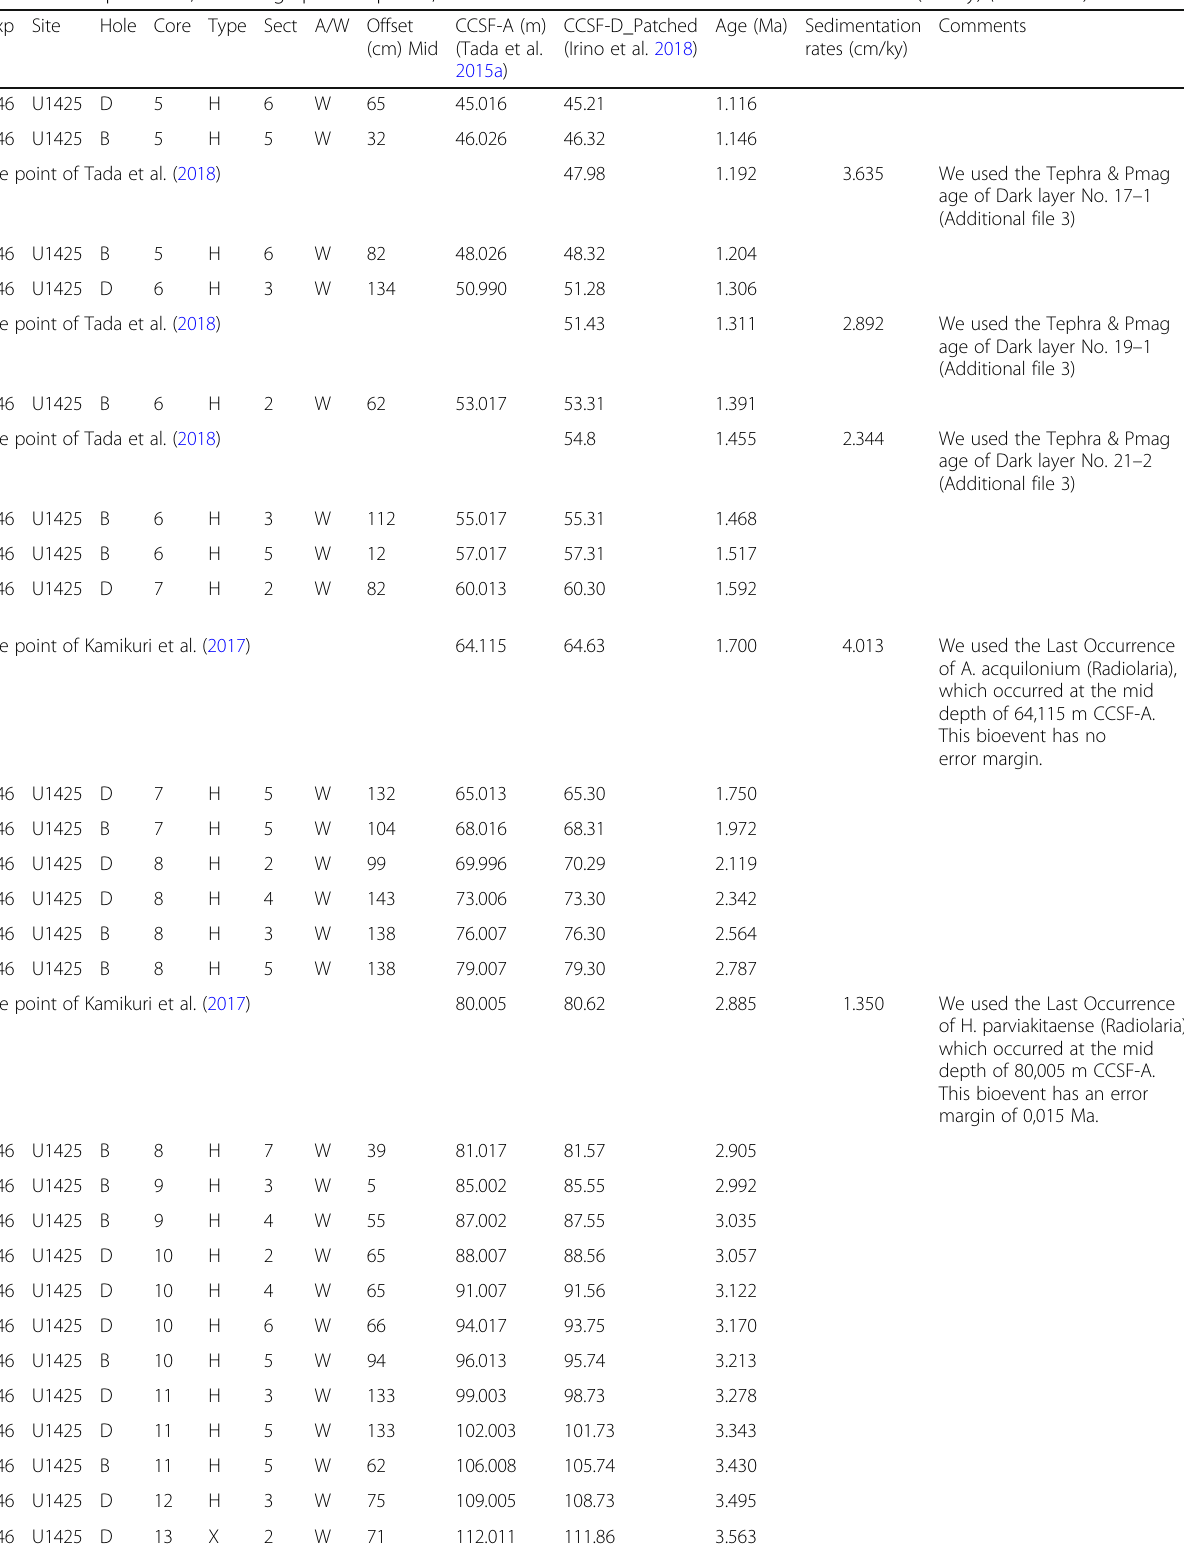
Table 1 Samples used, biostratigraphic tie points, and related sedimentation rates at IODP Site U1425 (cm/ky) (Continued) Exp